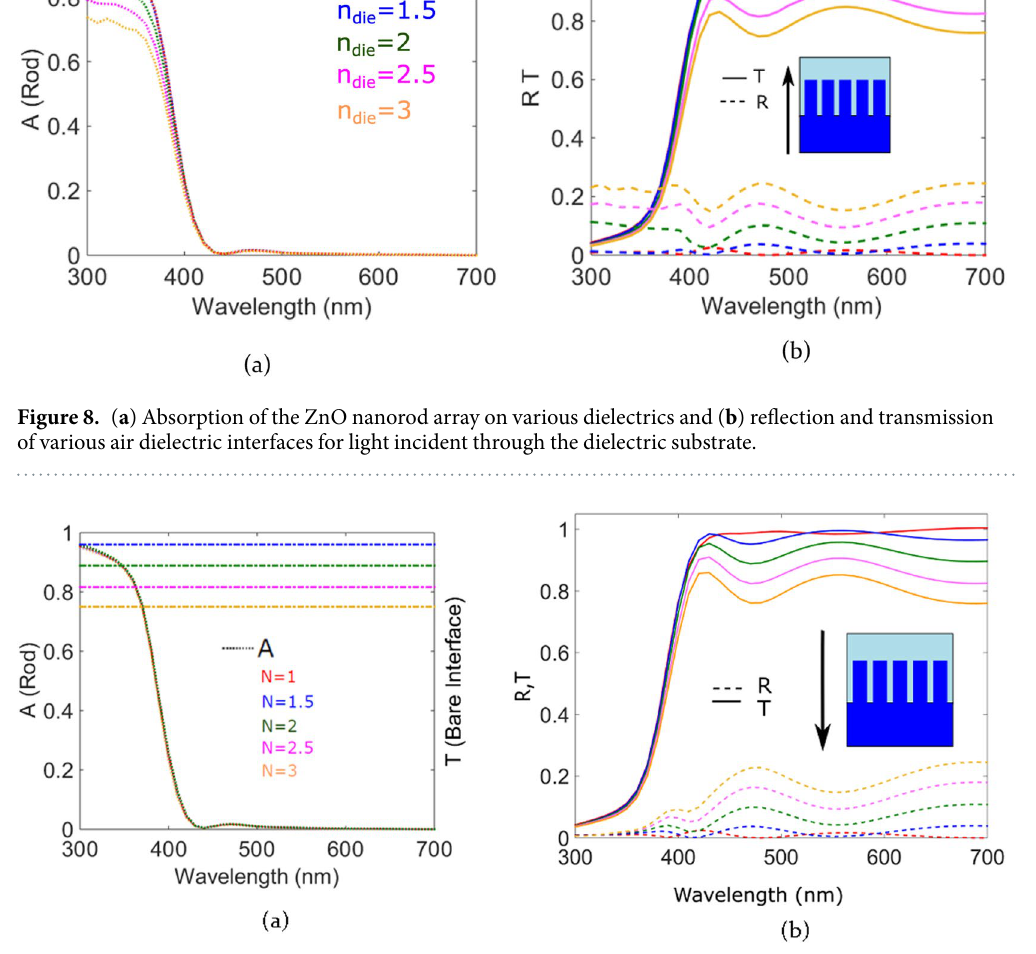
Figure 9. ( a ) Absorption of ZnO nanorod array on various dielectrics and the transmission values for bare interfaces and ( b ) reflection and transmission of various air dielectric interfaces with the nanorod arrays with light incident on the nanorod